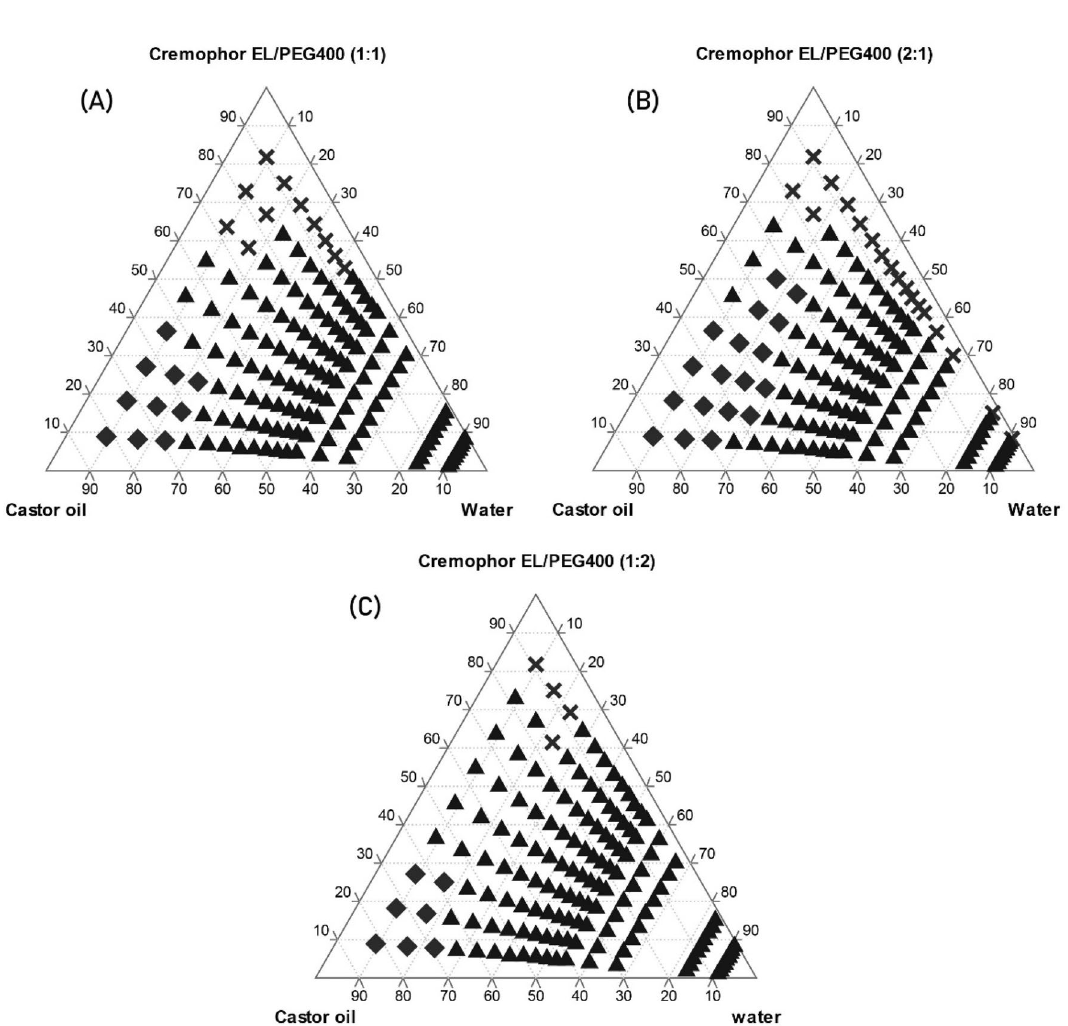
Figure 2. Pseudo-ternary phase diagrams of Cremophor El /PEG400:Castor oil:water with different Cremophor El/PEG400 ratios: (A)1:1, (B)2:1 and (C)1:2. ( X ) Represents the concentrations at which a clear/ translucent emulsion was formed. (diamond) Gel-like phase. (triangle) White